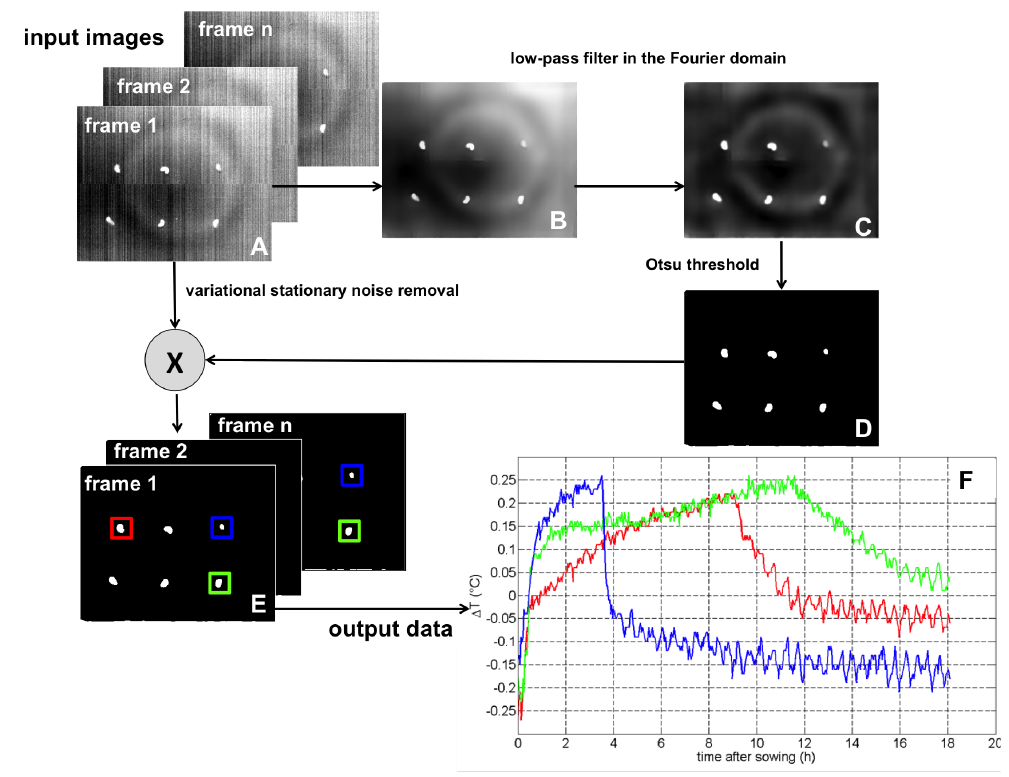
Figure 3. Main steps of the image processing pipeline performing 2D segmentation of thermographic images, with the illustration of extracted output data in ( F ). The three colored curves were obtained by a computation of the difference between the average temperature of three distinct seeds and the average temperature of the background surrounding the seeds, delimited by colored squares, respectively red, green and